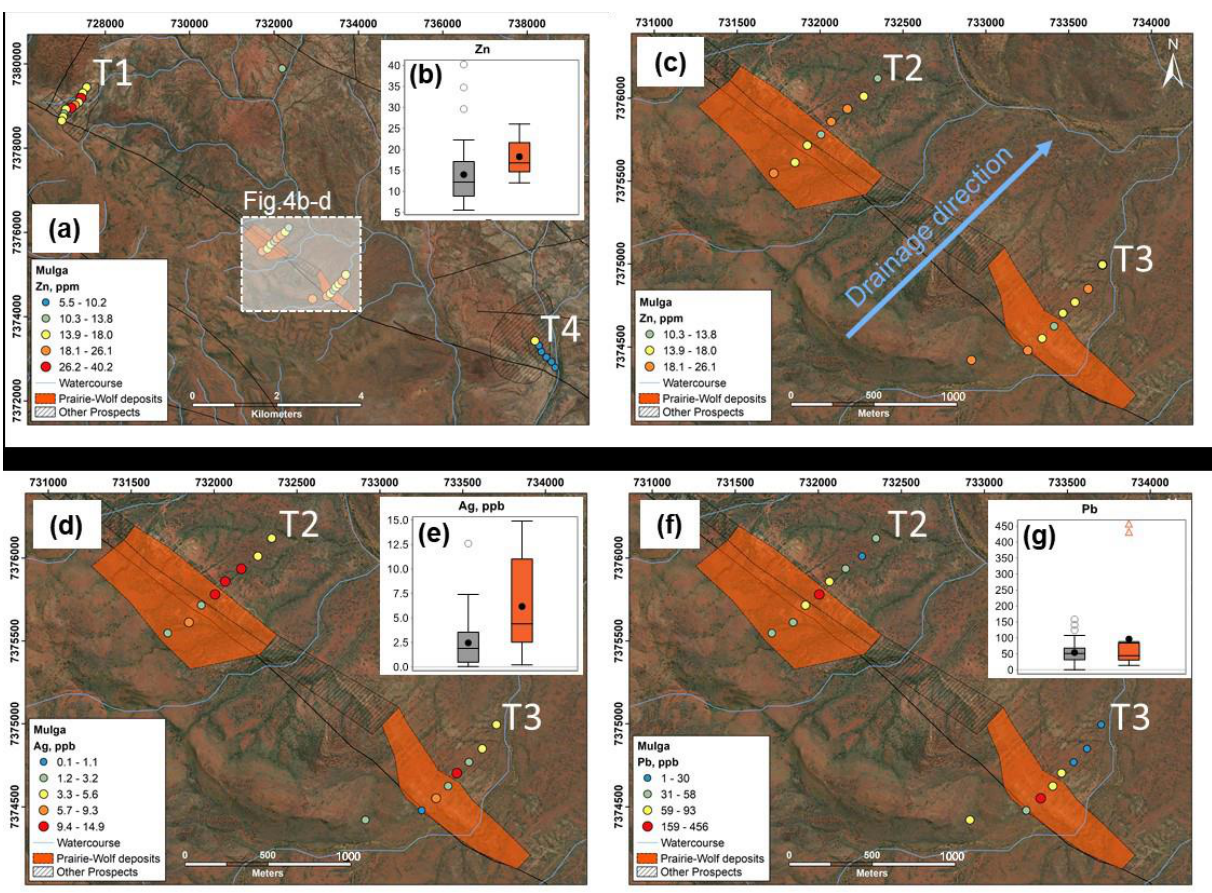
Figure 4. Metal concentrations in mulga phyllodes along transects T1 (Husky prospect), T2 (Wolf deposit), T3 (Prairie deposit) and T4 (Anomaly B prospect) and box plots. ( a ) Zn concentrations along all four transects. ( b ) Box plot of Zn (ppm) in mulga phyllodes. ( c ) Zinc concentrations along the Wolf (T2) and Prairie (T3) transects. ( d ) Silver concentrations along the Wolf (T2) and Prairie (T3) transects. ( e ) Box plot of Ag (ppb) in mulga phyllodes. ( f ) Lead concentrations along the Wolf (T2) and Prairie (T3) transects. ( g ) Box plot of Pb (ppb) in mulga phyllodes. Triangles in box plots indicate far outliers.